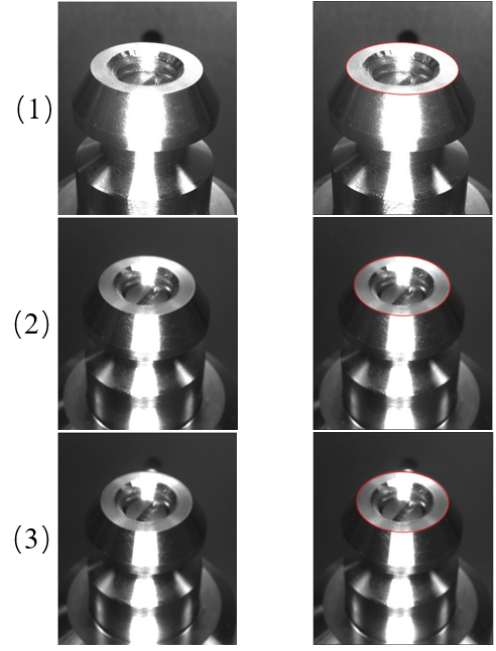
Figure 7. Ellipse-detection-result diagram.